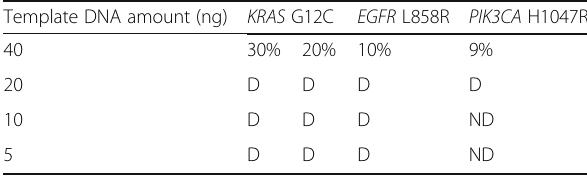
Table 4 MS assay sensitivity considering various percentages of mutated alleles with serially diluted DNAs from three FFPE sample